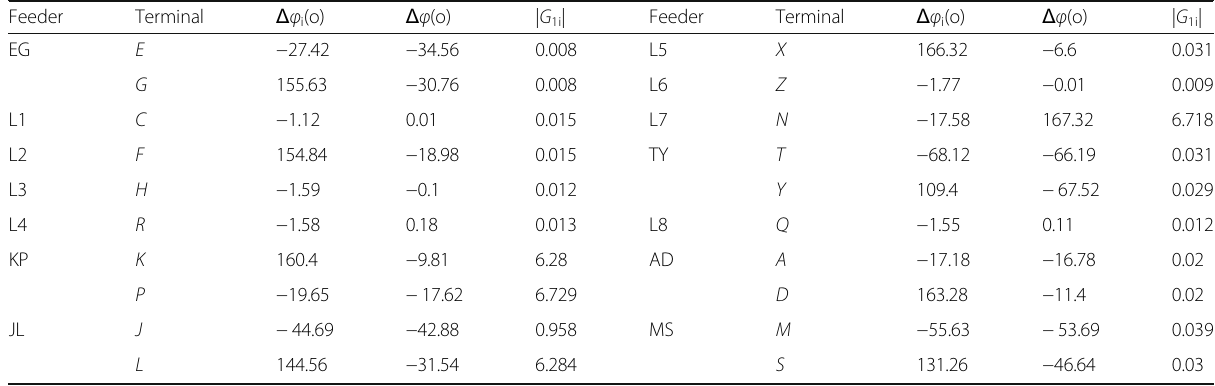
Table 6 Measured admittance results when the F2 fault occurs Feeder